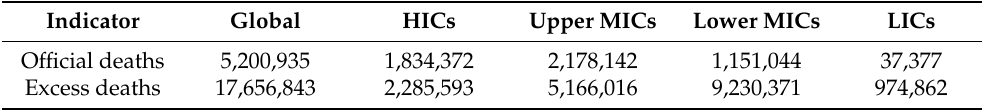
Table 1. Global estimates of the mortality burden of COVID-19 as of 1 December